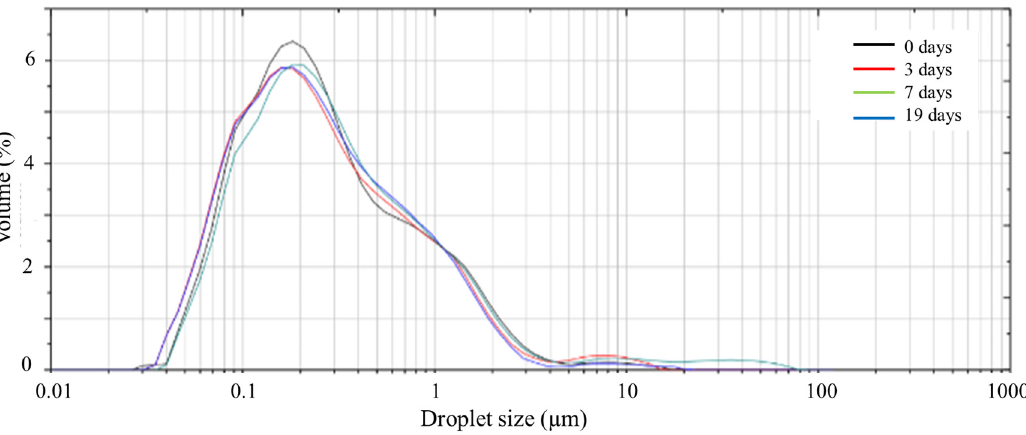
Figure 5. Evolution of droplet size distribution at different days of the emulsion at 2.0 wt% of soy protein isolate, pH 2 and processed at 120 PSI.